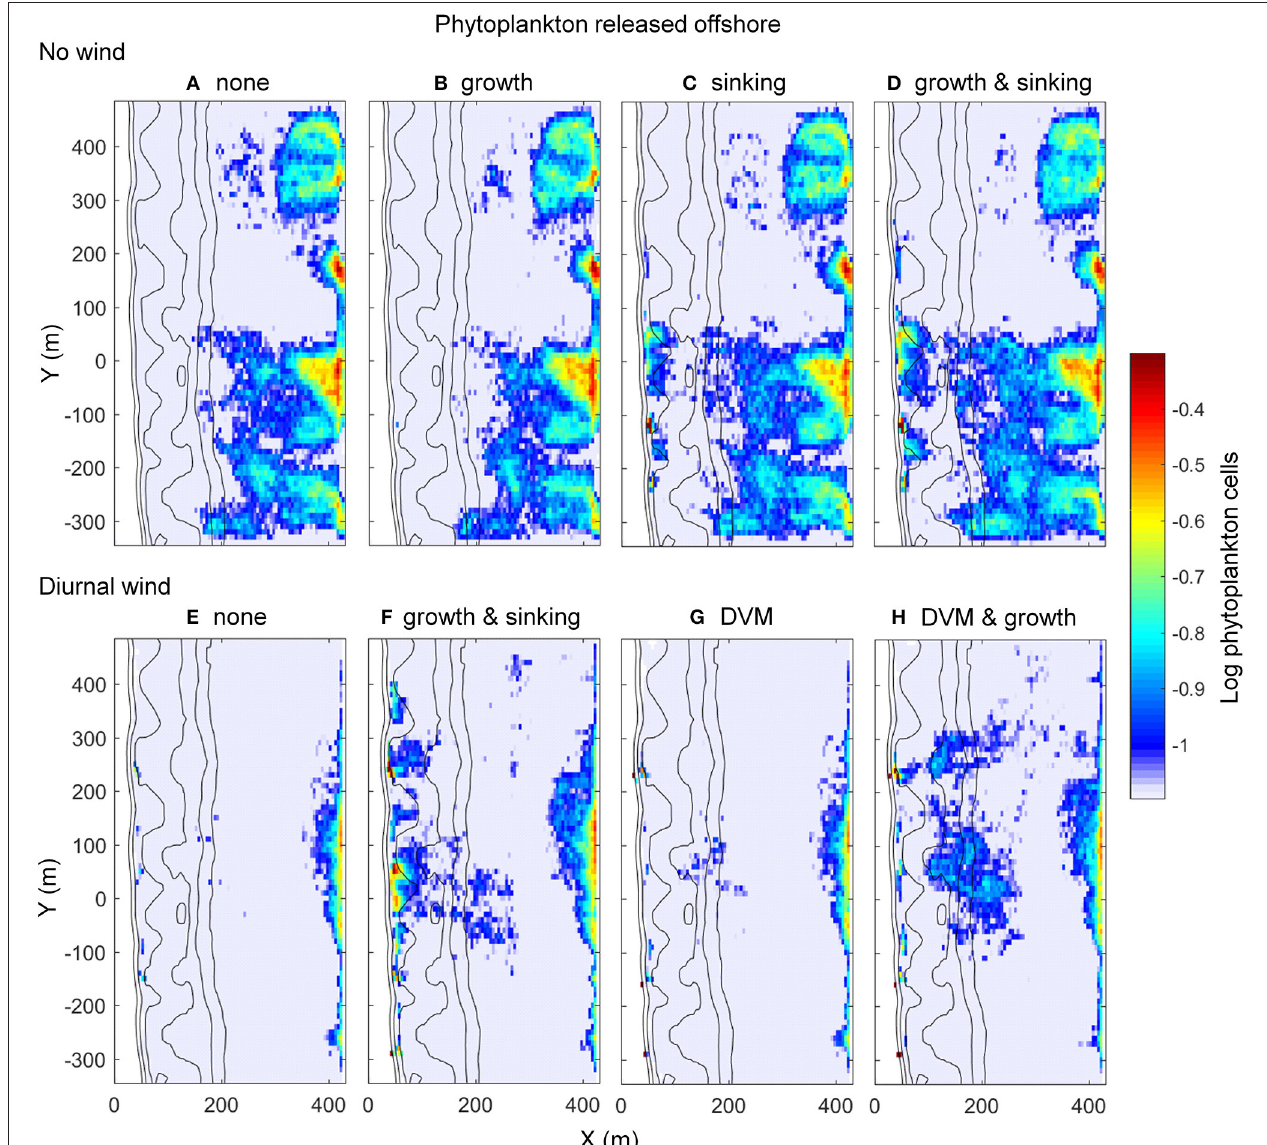
FIGURE 5 | Depth- and time-averaged number of cells per grid cell. Phytoplankton cells released offshore in (A–D) no-wind and (E–H) diurnal wind regime. Phytoplankton cells with (A,E) no growth, sinking, or DVM, (B) turbulence-driven growth, (C) turbulence-driven sinking, (D,F) both turbulence-driven growth and sinking, (G) DVM, and (H) DVM and depth-varying growth. Isobaths from 0m (shoreline) to 5m with 1m increments are given.